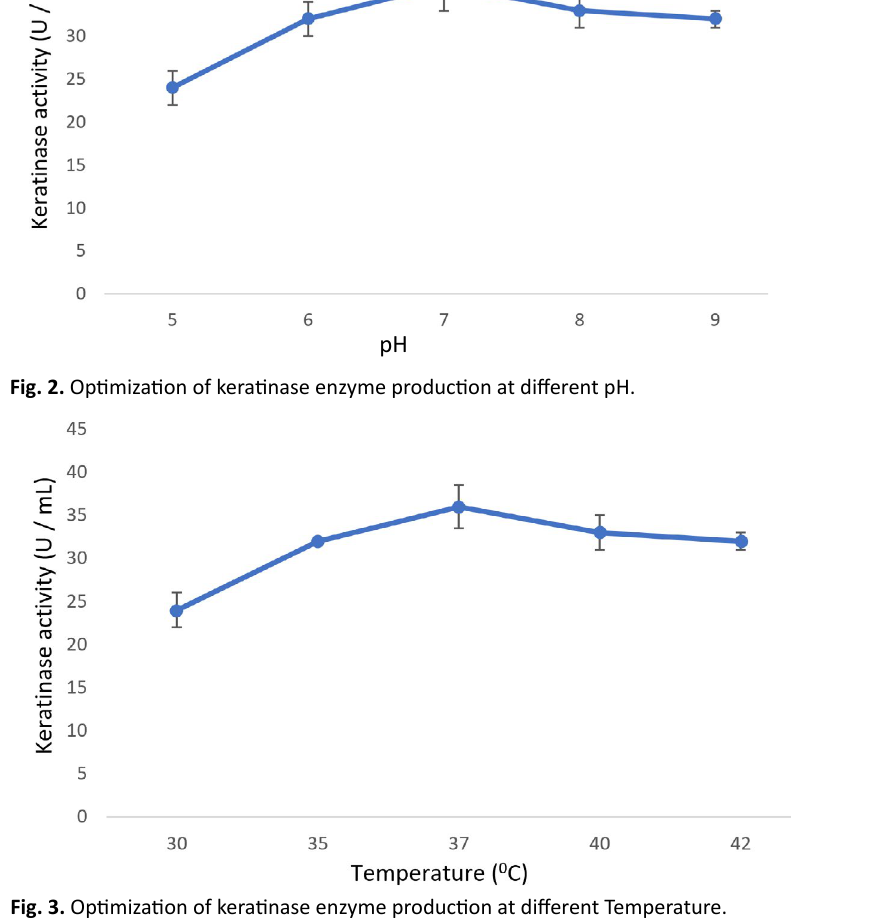
Fig. 3. Optimization of keratinase enzyme production at different